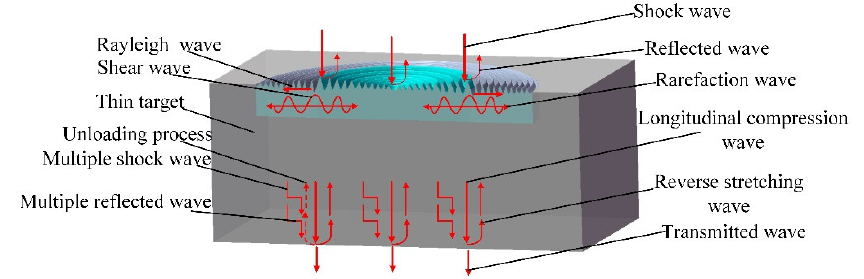
Figure 13. Propagation model of laser shock wave in E690 high-strength steel sheet.